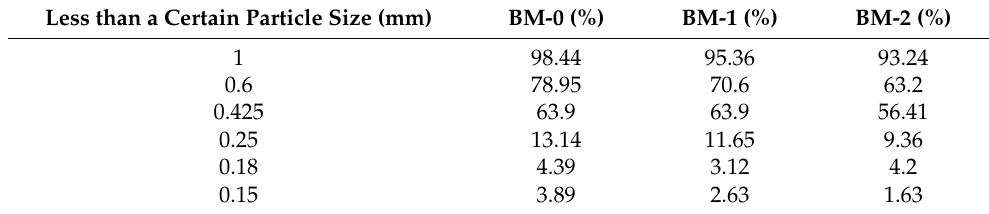
Table 2. Mass percentage of sieving.